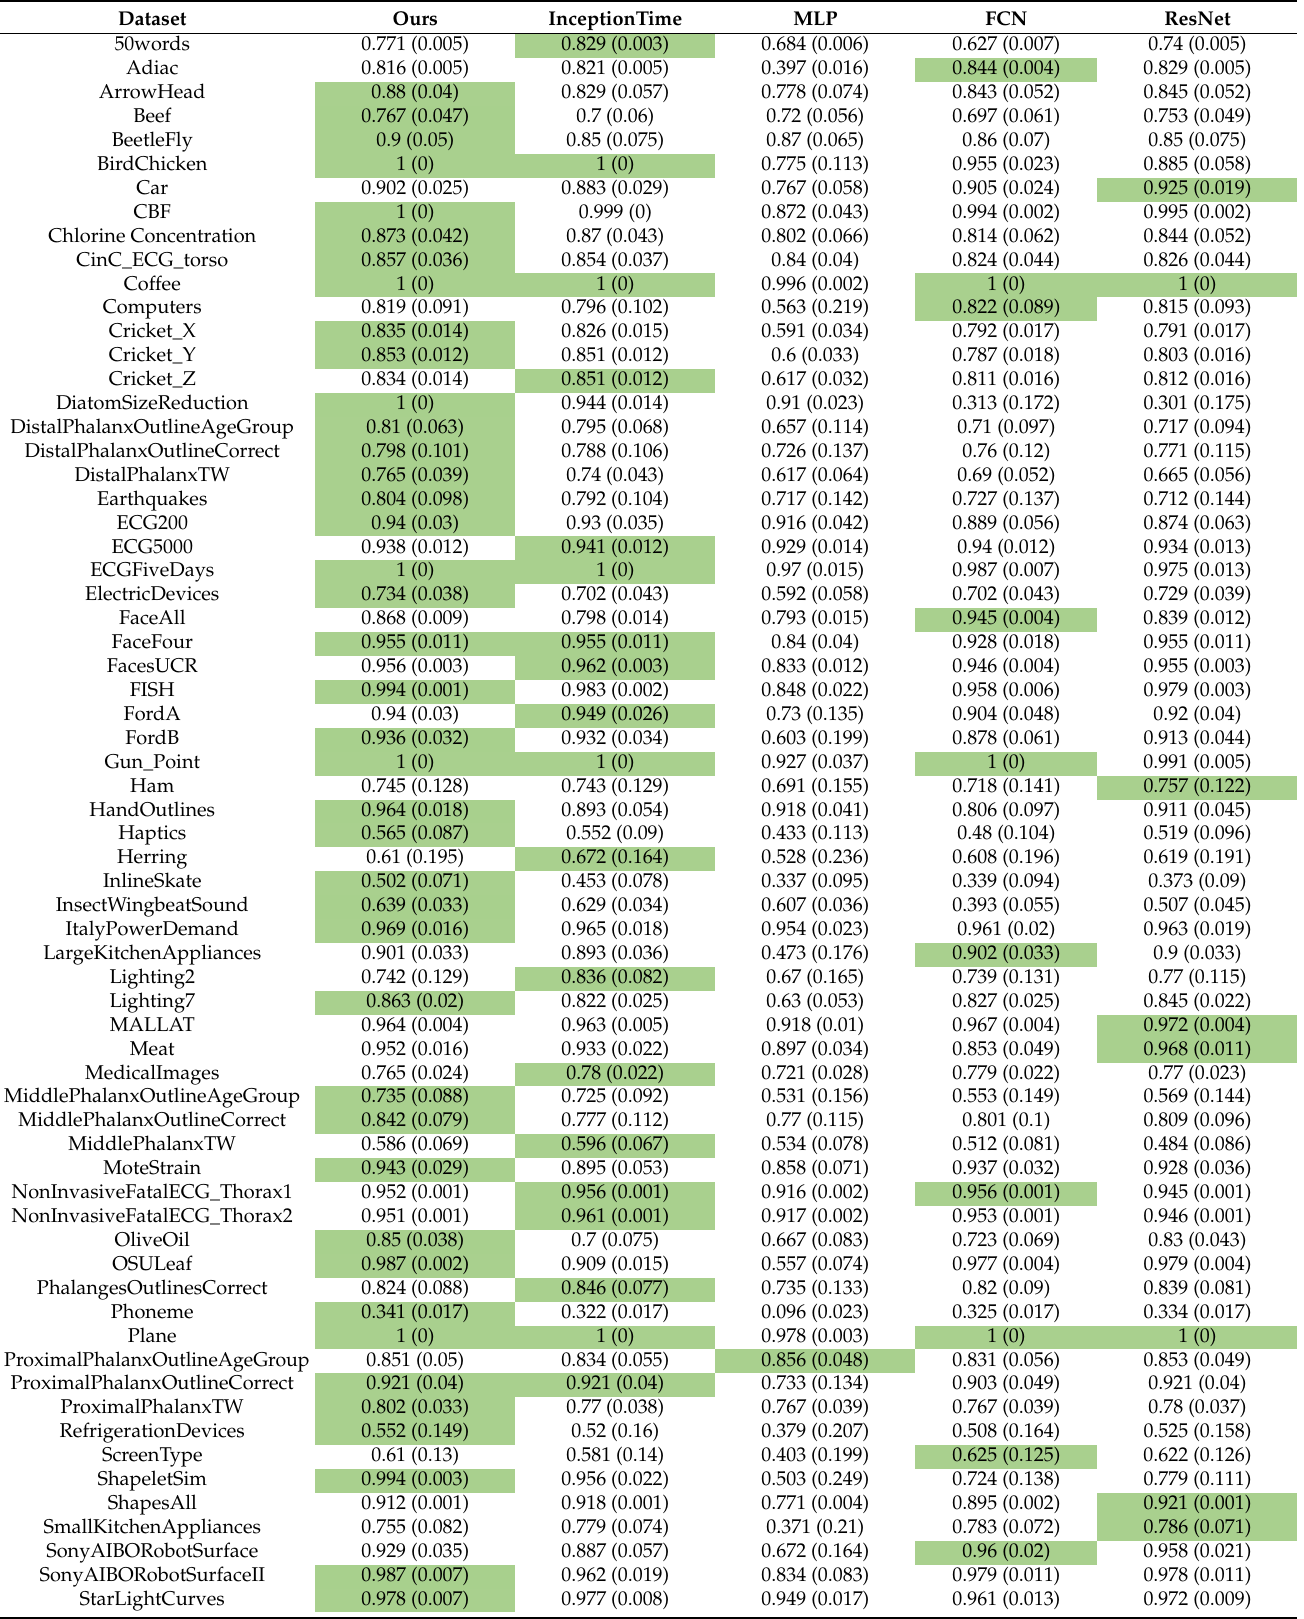
Table 2. Testing accuracy and per class error rate (PCE) for five different networks on UCR-85 dataset. Green color shows the winner in accuracy